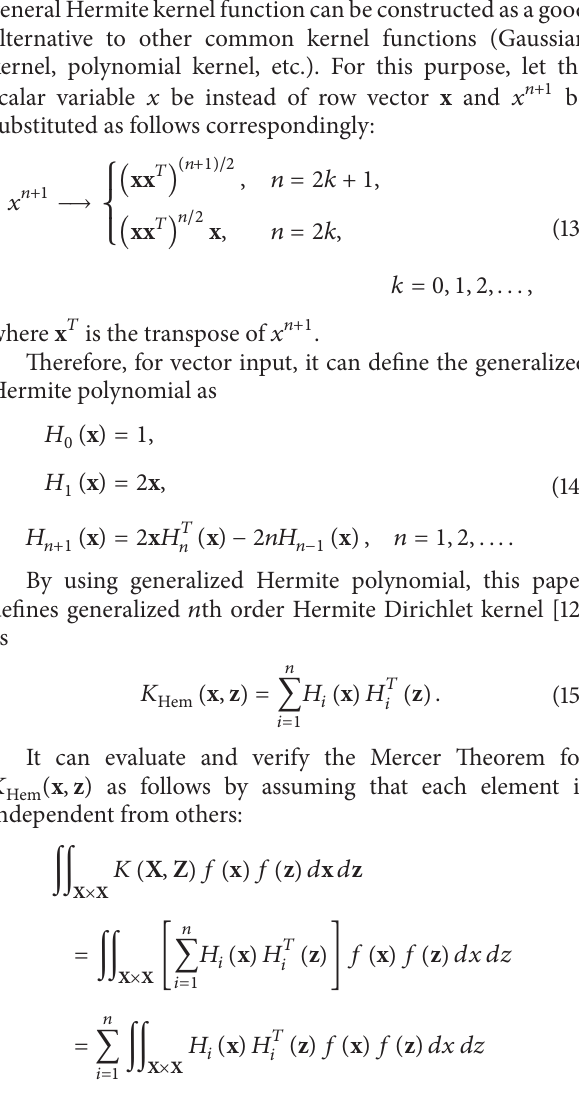
Figure 2: The graph of 𝐾 Gau ( x , z ) and 𝐾 Tri ( x , z ) , where 𝑧 = 0. 2.